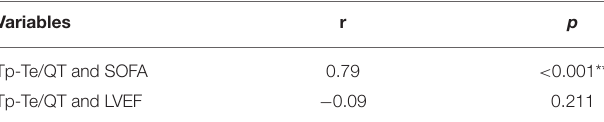
TABLE 6 | Correlation analysis of Tp-Te/QT with SOFA and